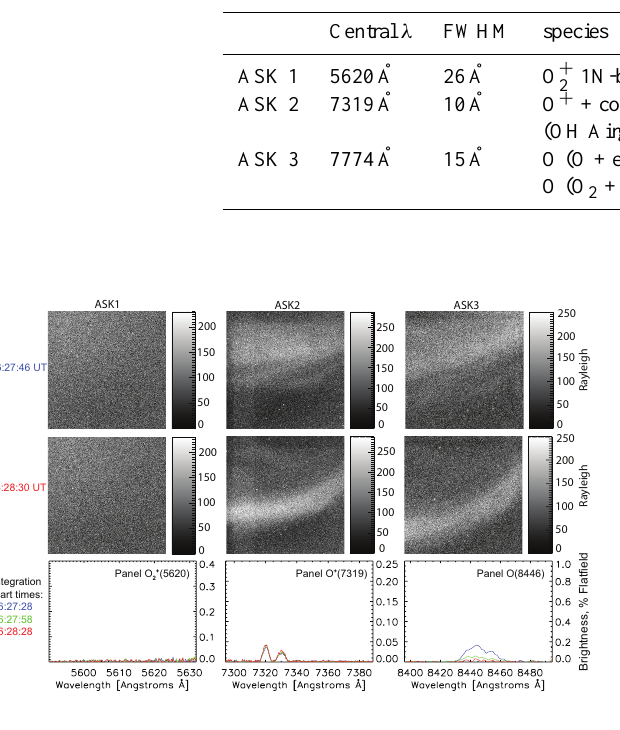
Fig. 2. ASK images and SIF line spectra from event 1, 2 January 2006, 16:00 UT. The top two rows of panels show ASK images from two different times during this event. The auroral arc seen in ASK2 and ASK3 is not detectable in ASK1, and the corresponding SIF line spectra (third row) confirm that the O + noise level.